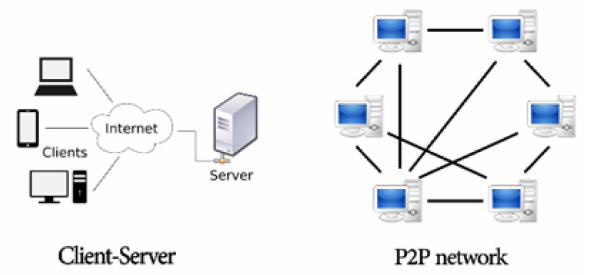
Figure 6. BCT Configuration.